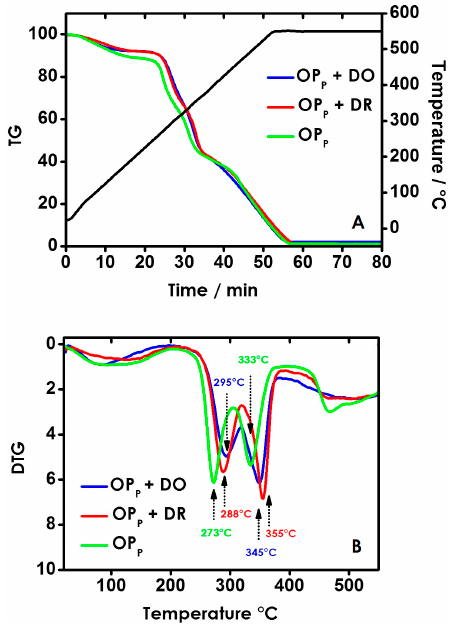
Figure 2. Thermogravimetric analyses (TG) of OP P (Black line), and OP P + DO, OP P + DR composite materials (blue and red lines) ( A ); differential Thermogravimetric analyses (DTG) of the same samples ( B ).